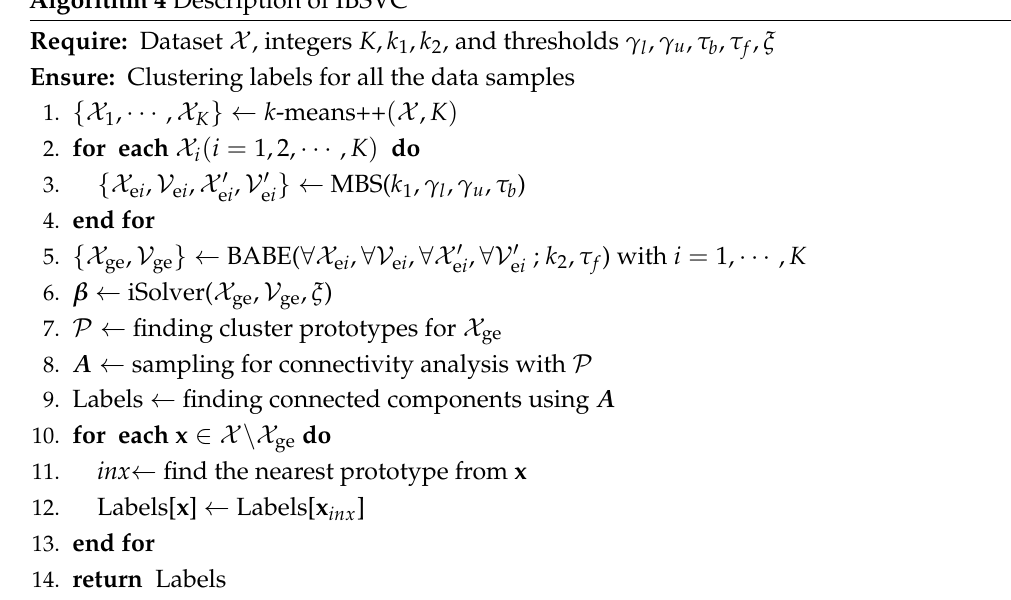
Algorithm 4 Description of